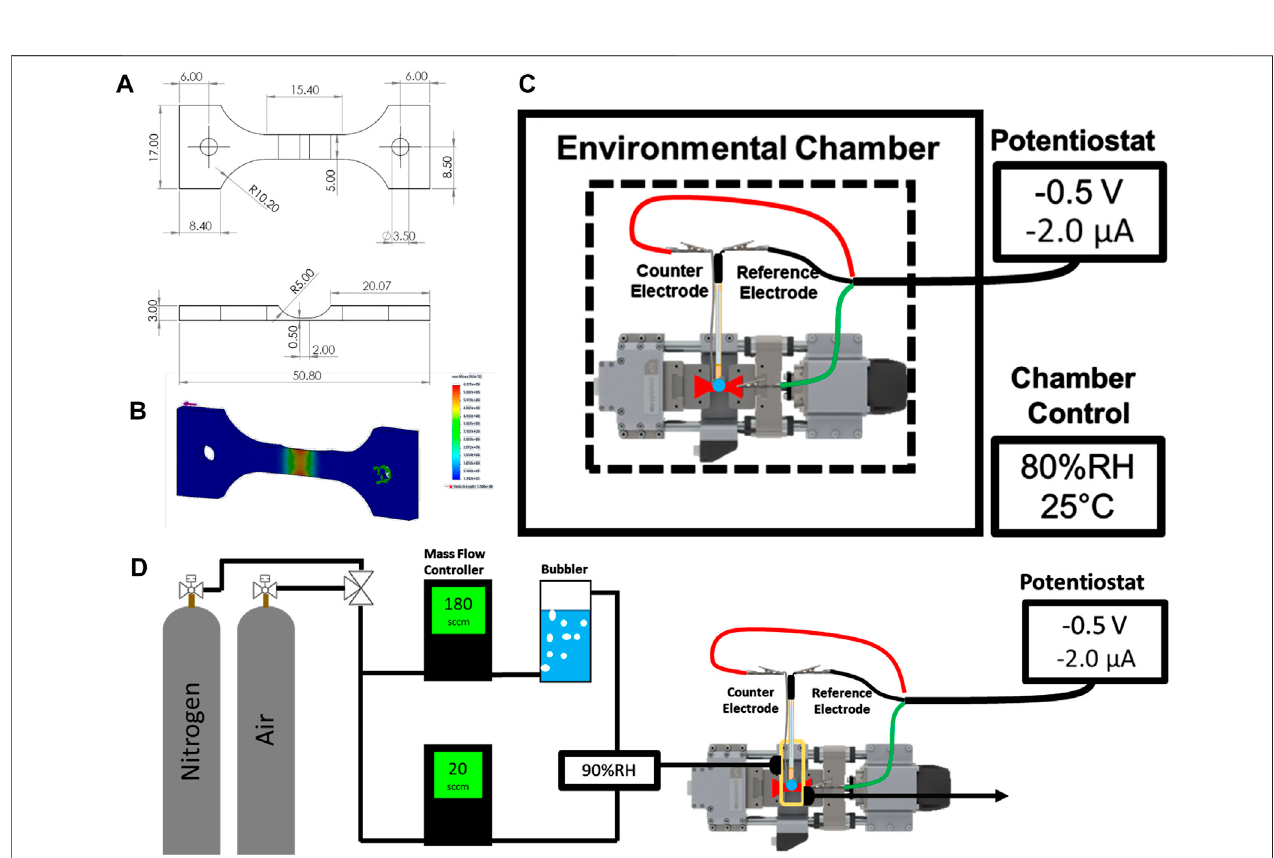
FIGURE1| Schematicofthemachinedsample(mm) (A) andthecorrespondingstaticstressanalysis (B) .Schematicsfortheenvironmentalchambercon fi guration (C) and gas fl ow cell (D) are shown with labeled components.